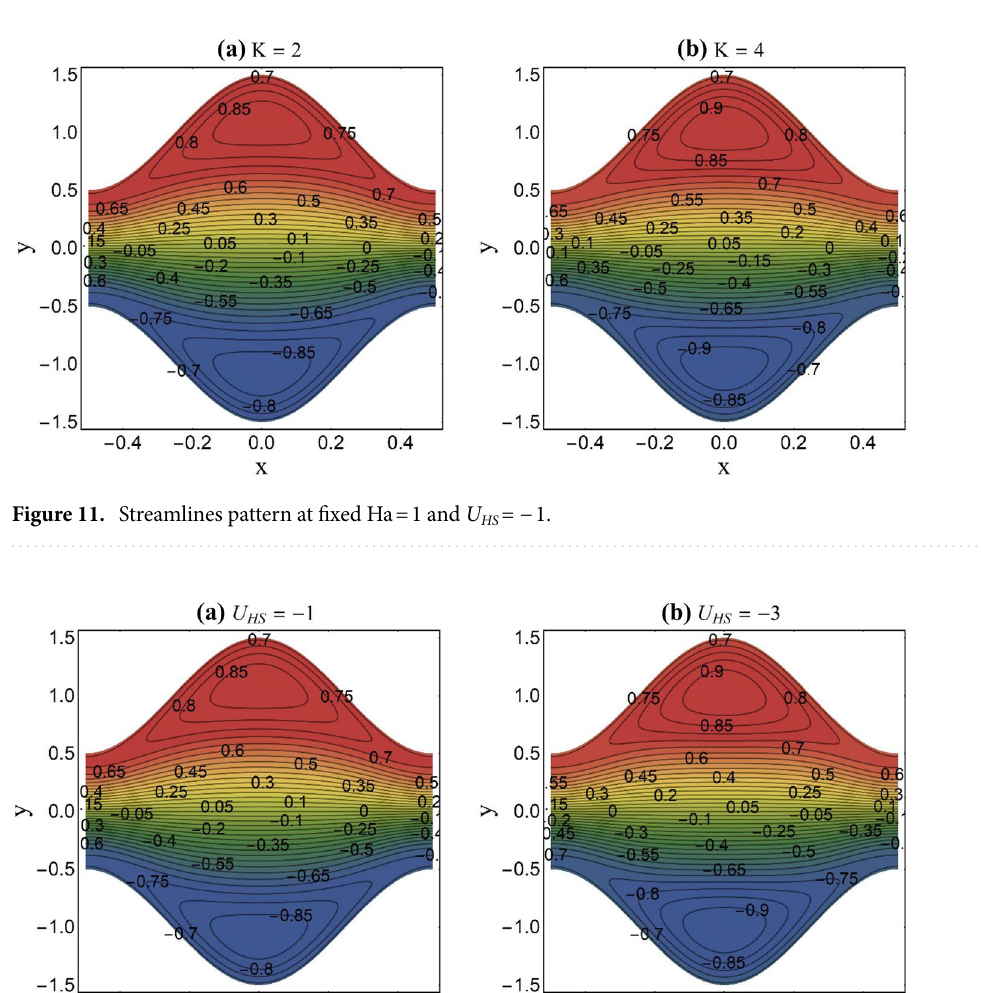
Figure 10. Streamlines pattern at fixed K = 2 and U HS = − 1.